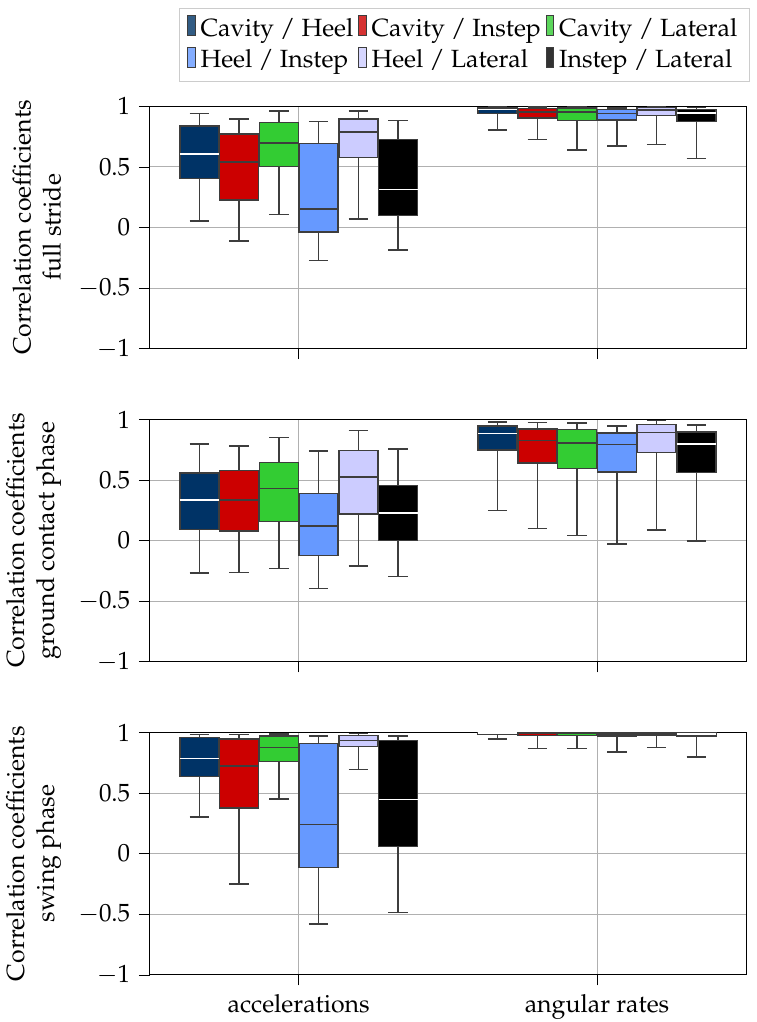
Figure 8. Results of the evaluation of the Pearson’s correlation coefficients between the IMU raw signals. Each box visualizes the correlation coefficients between two sensors for all the strides in x , y , and z direction. The box plots also display the median of the correlations (median line), the IQR (box), and the 5 and 95 percentiles (whiskers). The upper plot depicts the correlation of the full strides, the middle plot the correlations during the ground contact phase, and the lower plot the correlations during the swing